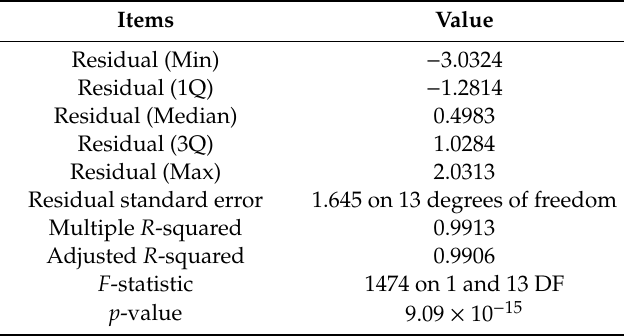
Table 3. Test results of equation